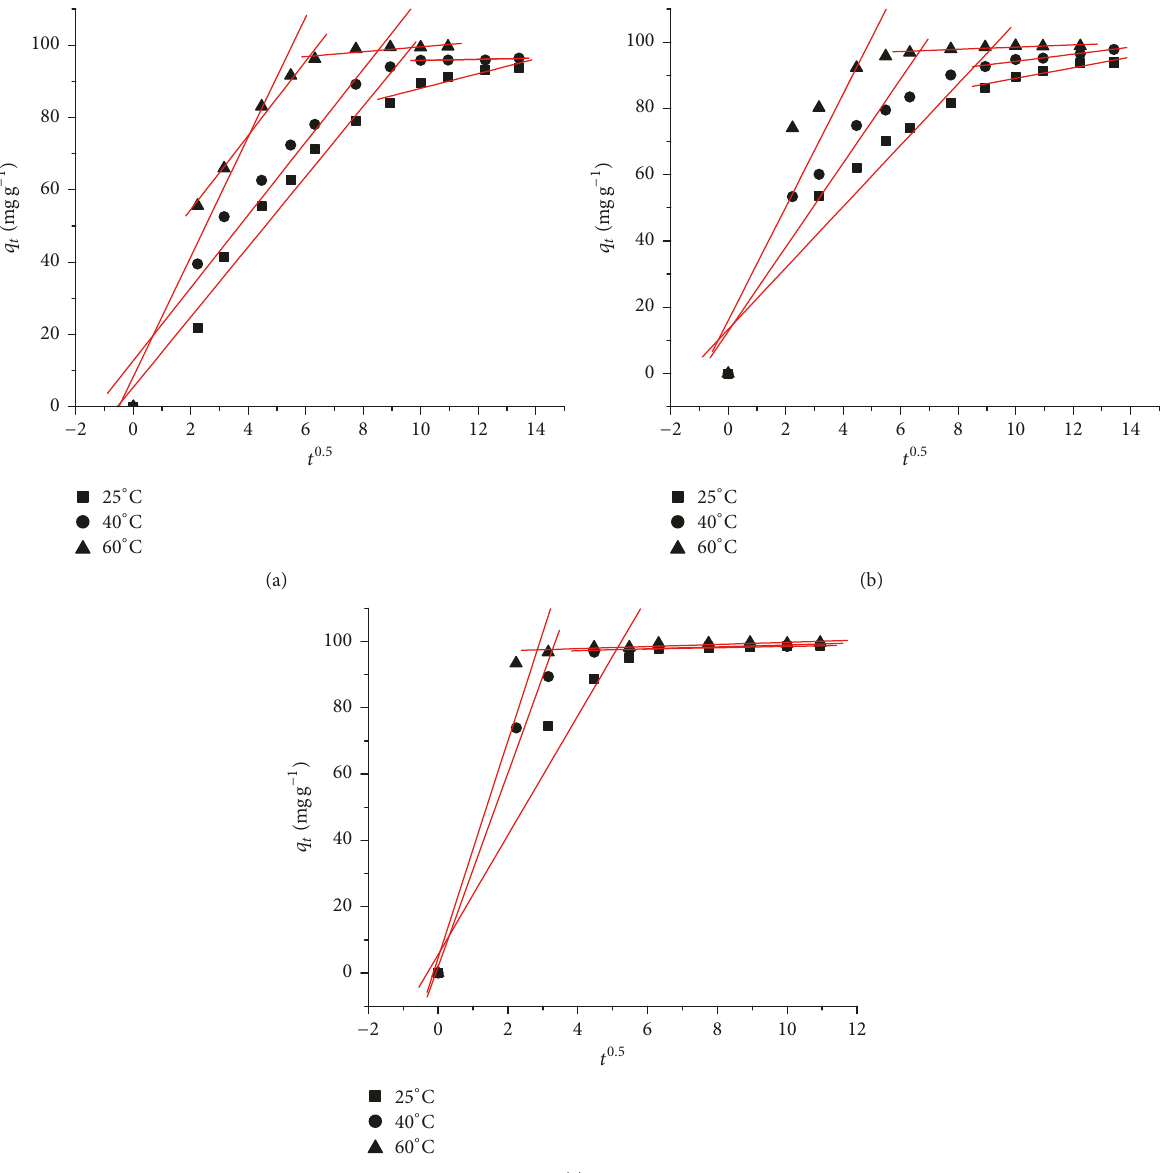
Figure 7: Intraparticle diffusion model applied for adsorption of (a) NB, (b) ChS, and (c) BR2 on PM-4